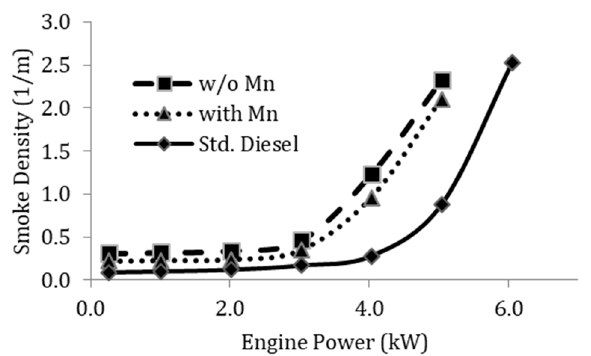
Figure 7. Effect of organic-based Mn additive on smoke density.